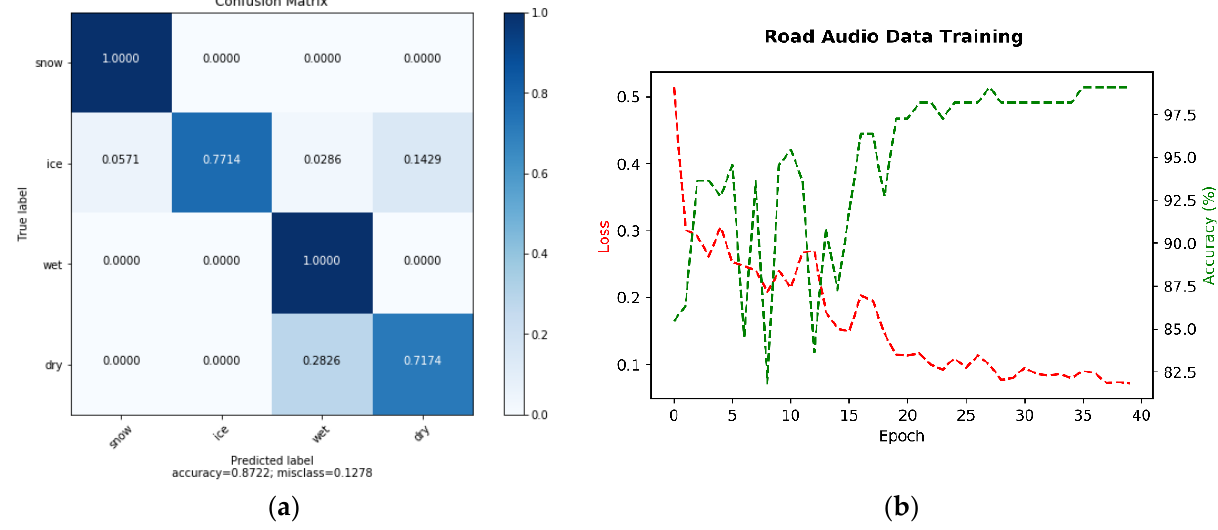
Figure 6. Analysis of the model that was generated for audio classification: ( a ) audio training and validation; ( b ) confusion matrix for the test set.